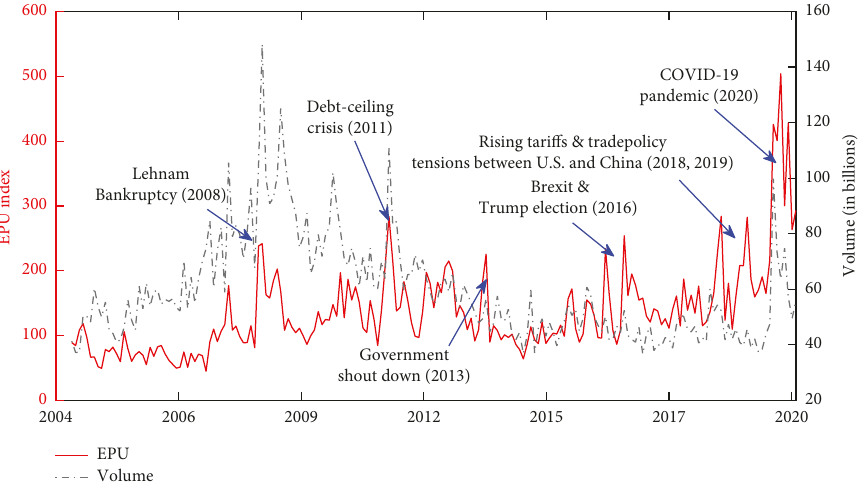
Figure 1: The monthly EPU index from July 2004 to September 2020. The events are based on those presented on the website. Table 1: Summary statistics of MATV in the S&P 500 index. Here, the statistics are obtained based on scale-adjusted MATV (divided by 10 million).